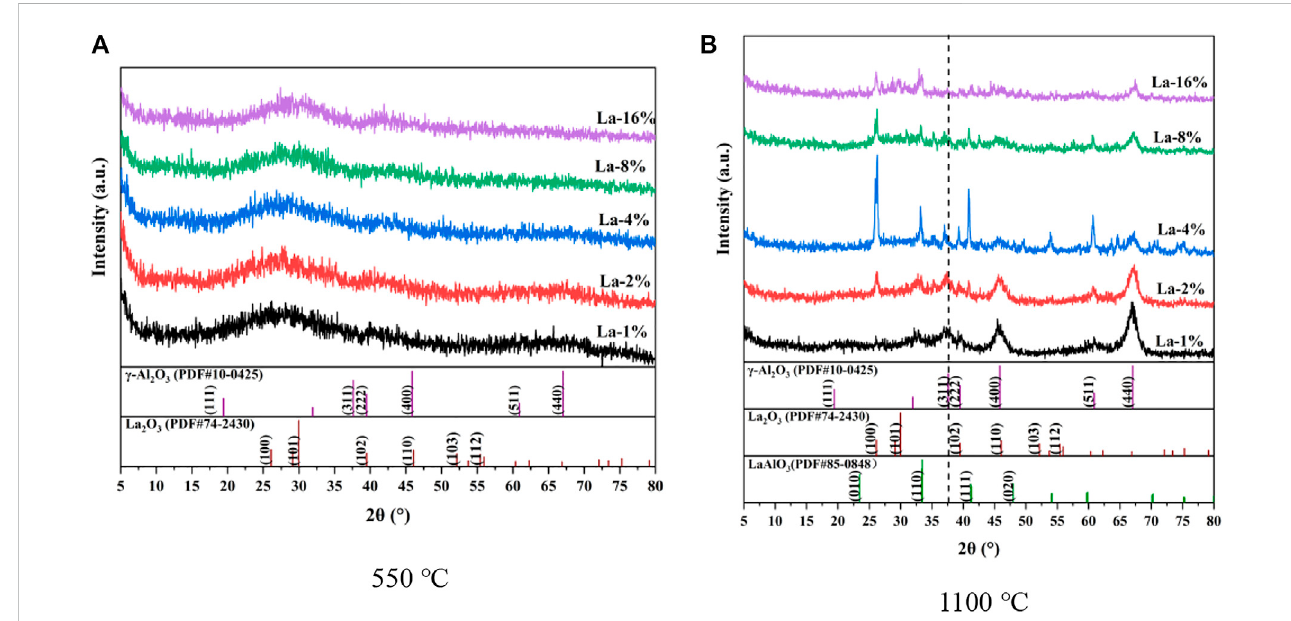
FIGURE 3 XRD pattern of La-doped sample calcined at 550 ° C and aged at 1,100 ° C.